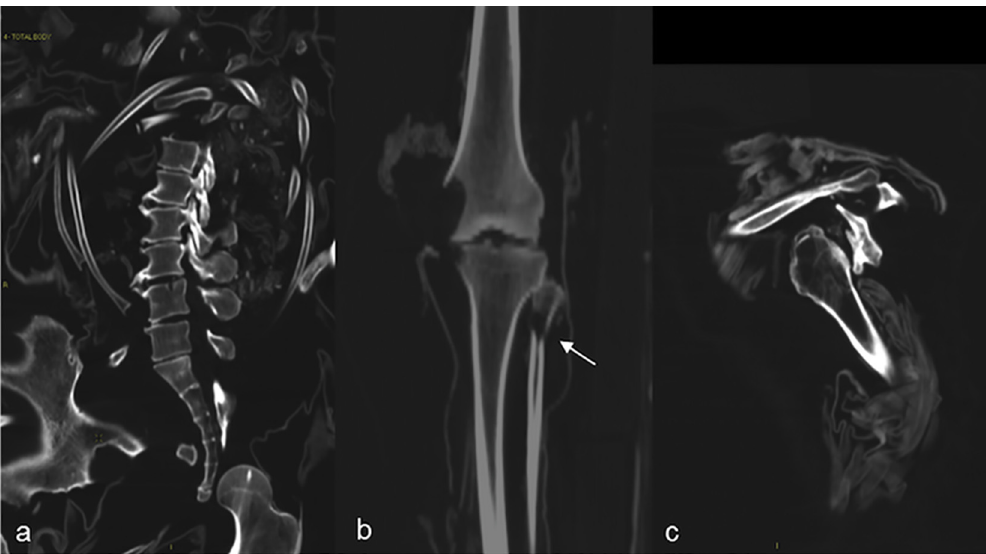
Fig 5. Degenerative signs of the lumbar spine, with moderate osteophytosis (a). Degenerative signs of knee with sclerosis of articular layers and osteophytosis. Fracture of proximal metaphysis of fibula without any bone reparative sign, suggestive of post-mortem fracture (arrow) (b). Sclerosis of the glena and irregularity of greater tuberosity